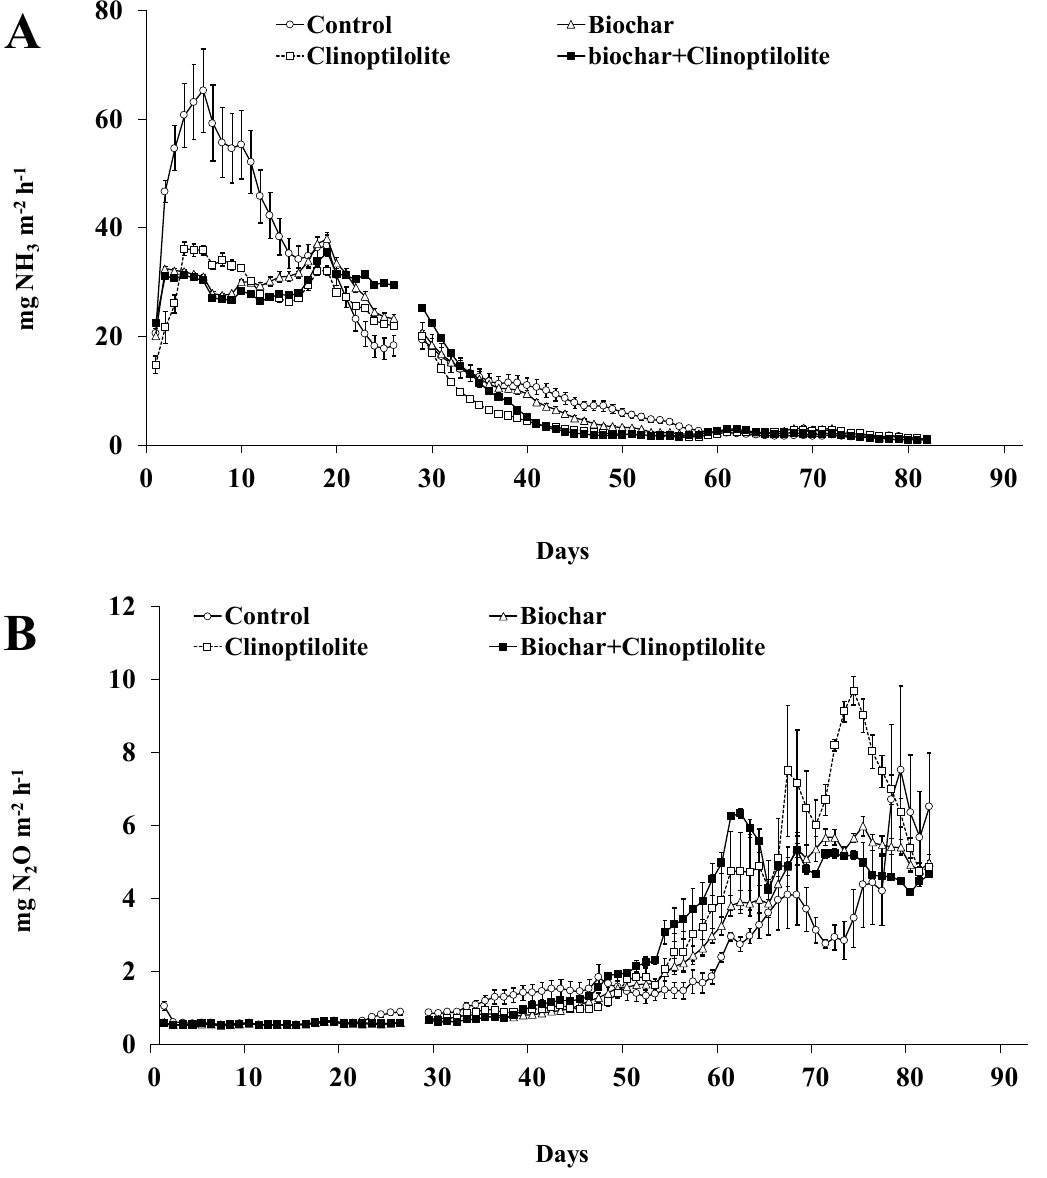
Figure 2. Ammonia ( A ) and nitrous oxide ( B ) fluxes from each treatment. Vertical bars represent the standard error of the mean ( n = 3). Table 3. Cumulative gaseous emissions from each treatment (mean ± standard deviation) ( n = 3).